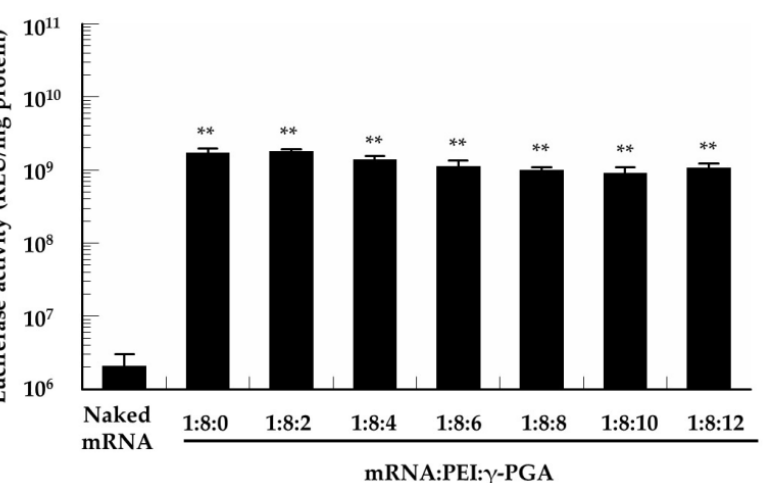
Figure 5. In vitro protein expression efficiency of the mRNA/PEI8/ γ -PGA complexes at various charge ratios (1:8:0, 1:8:2, 1:8:4, 1:8:6, 1:8:8, 1:8:10, and 1:8:12). B16 cells were treated with each complex containing 1 µ g of the mRNA for 24 h, following which, the luciferase activity was evaluated. Data represent the mean ± S.E. ( n = 3). ** p < 0.01 vs. naked mRNA.